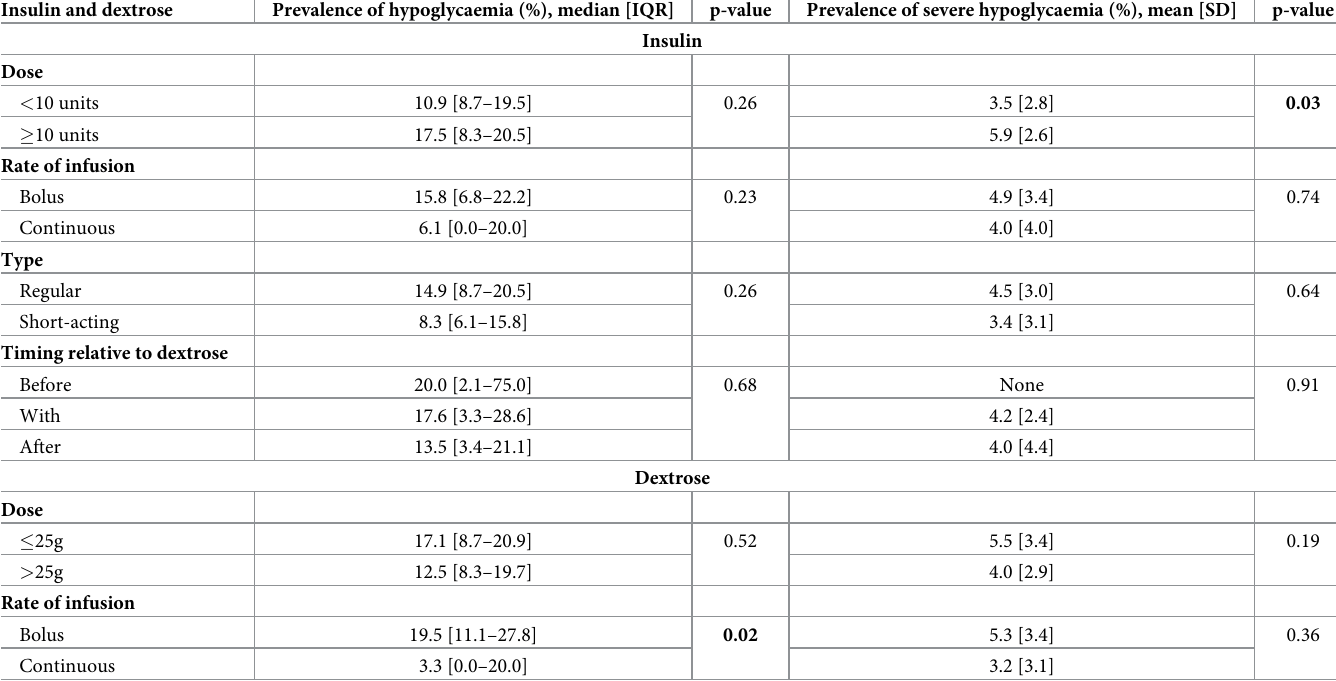
Table 4. Comparison of the prevalence of hypoglycaemia by insulin (dose, rate of infusion, type, and timing relative to dextrose) and dextrose (dose and rate of infusion). Insulin and